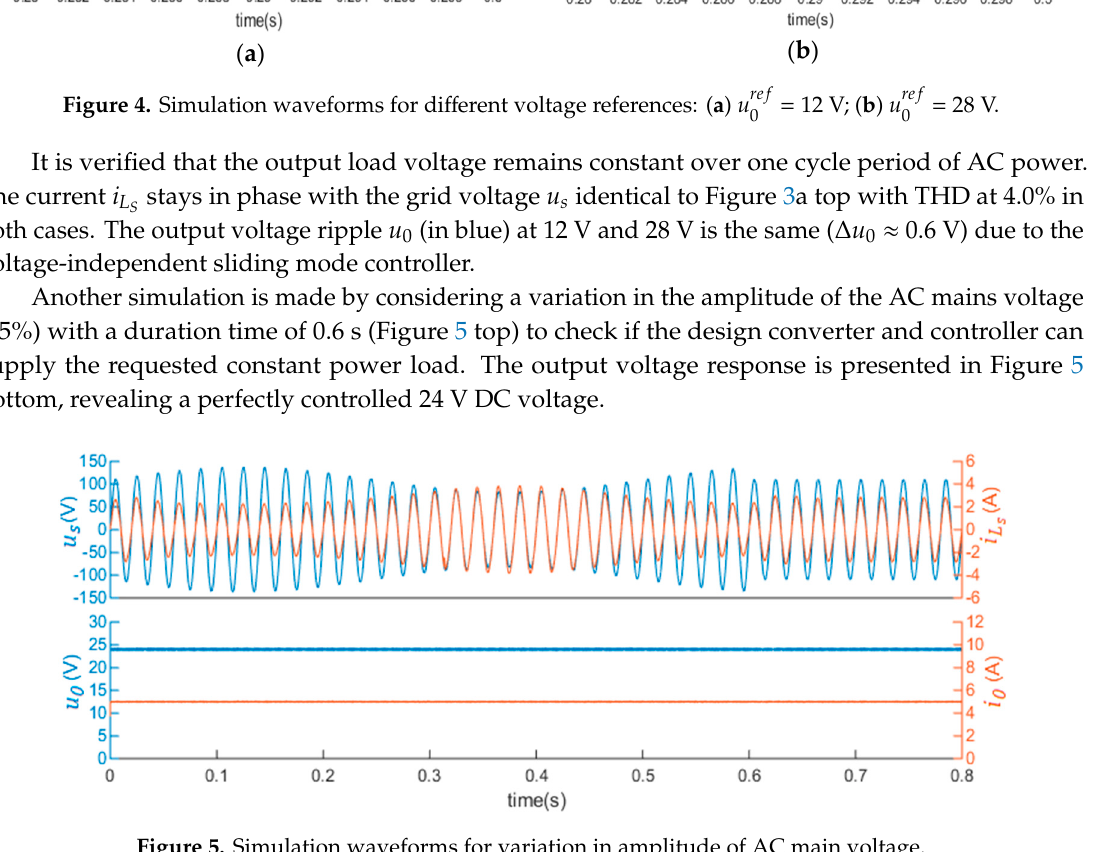
Figure 4. Simulation waveforms for different voltage references: ( a ) 𝑢 (cid:2868)(cid:3045)(cid:3032)(cid:3033) = 12 V; ( b ) 𝑢 (cid:2868)(cid:3045)(cid:3032)(cid:3033) = 28 V.